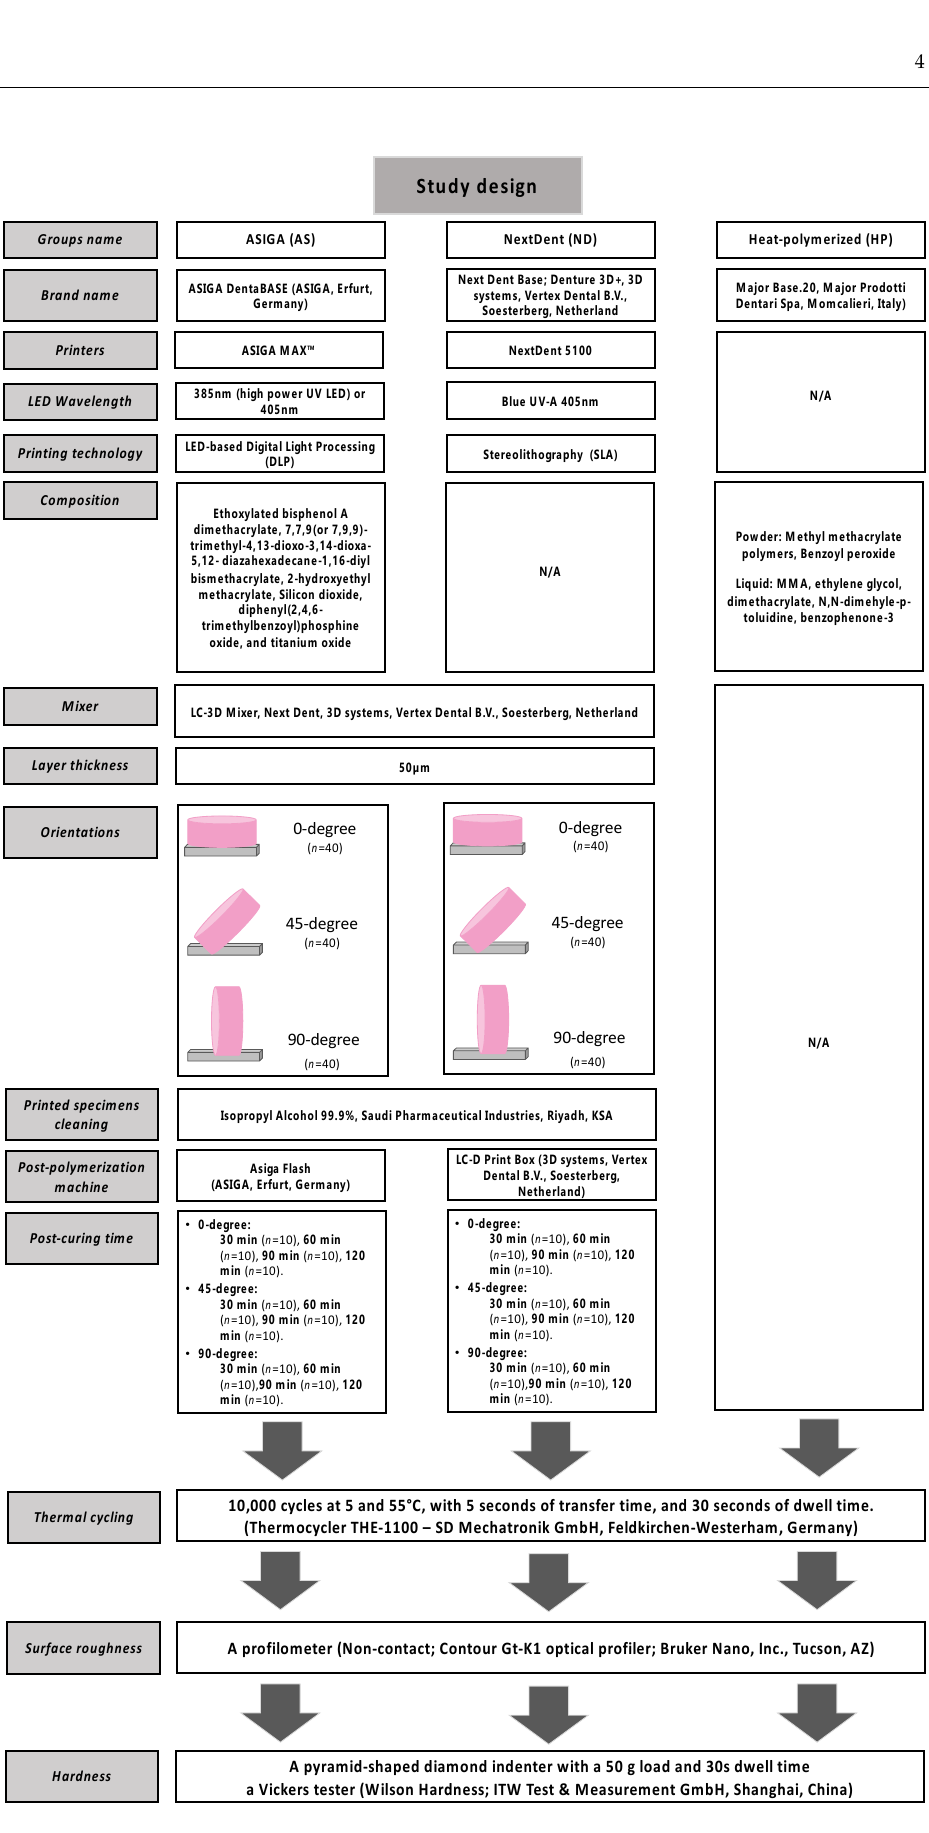
Figure 1. Study design and flowchart.